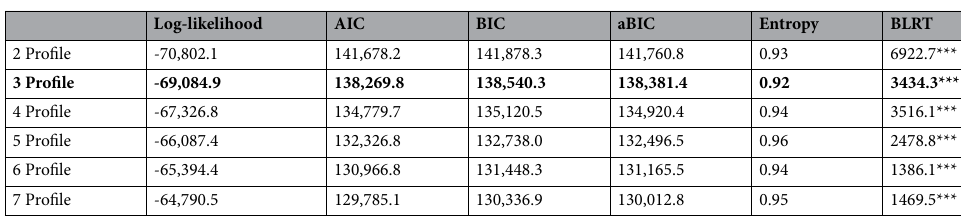
Table 2. Fit indices for different models with number of profiles ranging from 2 to 7. Note AIC Akaike’s Information Criterion, BIC Bayesian Information Criterion, aBIC Sample Size Adjusted BIC, and BLRT bootstrap likelihood ratio test. ***P value < 0.001. Models with a low AIC, BIC, and aBIC value and high Entropy value as well as significant Bootstrap Likelihood Ratio Test (BLRT) were preferred. Bolded Fit Indices indicate that the 3 profile is optimal latent profile model, The selected (3 profile) has been bolded.